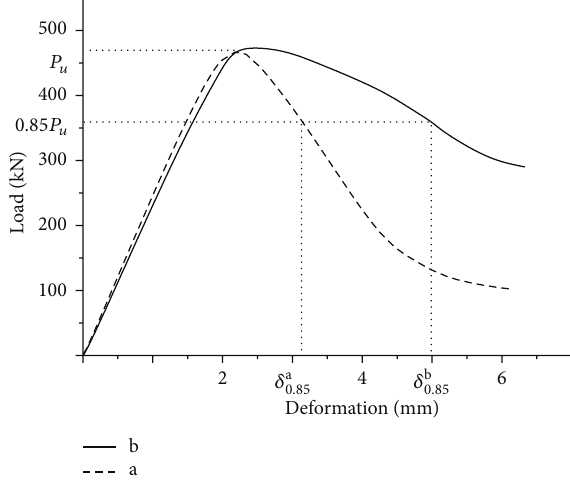
Figure 5: Comparative analysis of the different